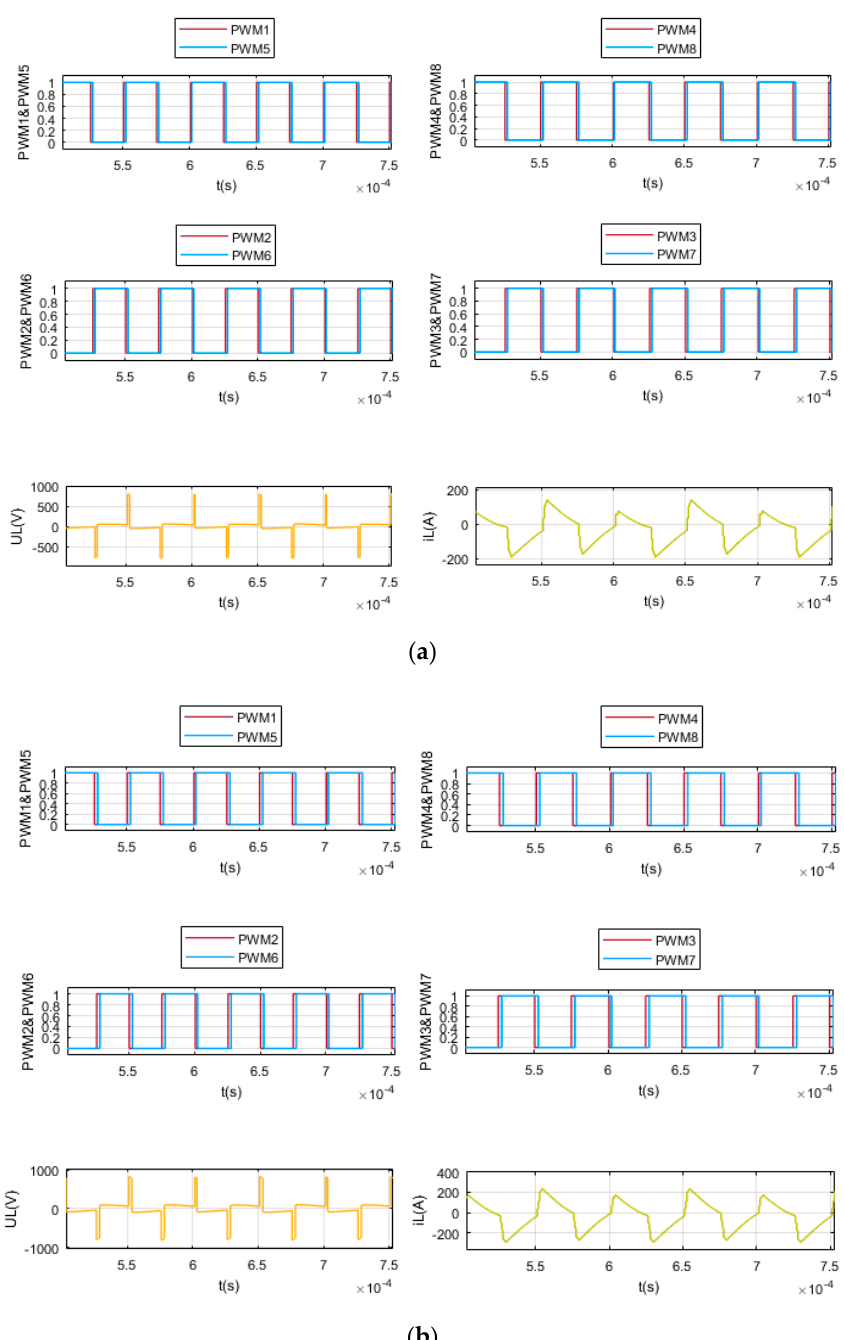
Figure A2. Detailed Simulation waveform diagram of the drive signal when U dc initial voltage is 749.7 V and U o initial voltage is 75 V: ( a ) MPC only for DAB; ( b ) MPC for DAB-SC system.